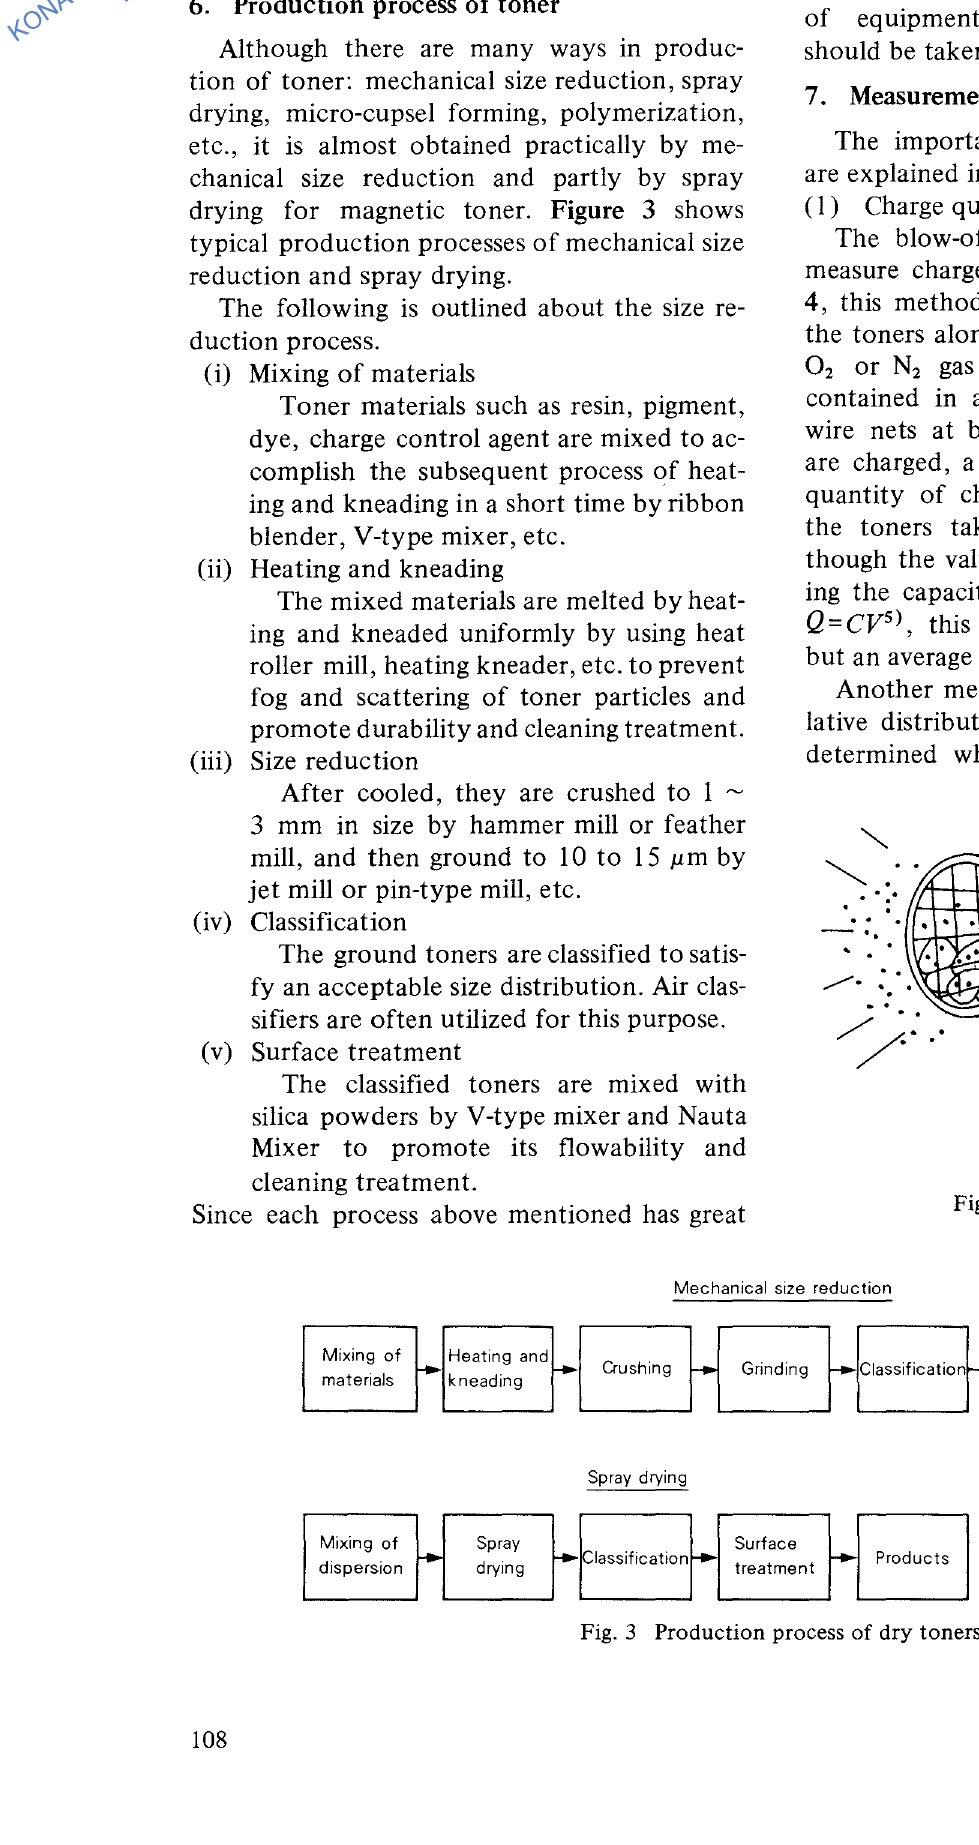
Fig. 3 Production process of dry